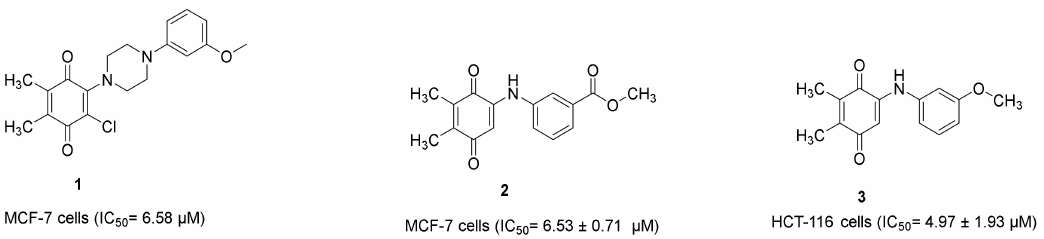
Figure 11. Our research group recently identified PQs to be endowed with anticancer properties against HCT-116 and MCF-7